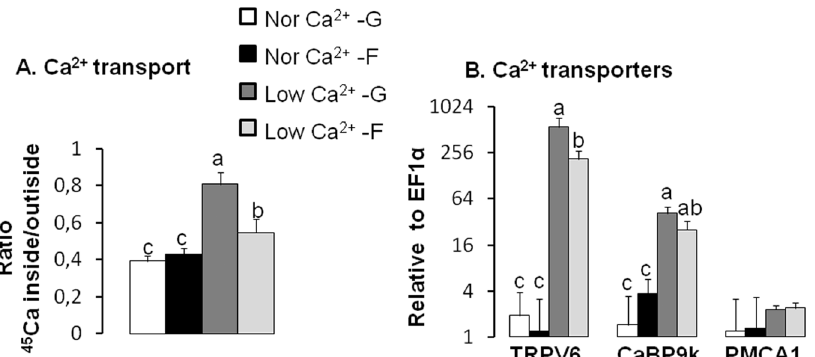
Figure 1. Fructose-fed mice demonstrate an inhibition of compensation for intestinal Ca 2 + transport rate and transporter expression induced by dietary Ca 2 + -deficiency. (A) Ca 2 + transport was measured using everted duodenal sacs from mice fed diets containing either 43% glucose or fructose, in combination with either normal or low Ca 2 + . Active transepithelial Ca 2 + transport from the luminal to the basolateral compartment was expressed as a ratio of the final quantity of 45 Ca 2 + inside/outside of the everted gut sacs. (B) mRNA expression levels of intestinal Ca 2 + (TRPV6, CaBP9k, PMCA1) transporters. All expression data were analyzed by real-time PCR using EF1 a as a reference and then normalized to levels in mice fed a normal Ca 2 + -glucose diet (Nor Ca 2 + -G). Data are means 6 SEM ( n =6 per group). Differences ( P , 0.05) among means are indicated by differences in superscript letters, as analyzed by 1-way ANOVA LSD. Thus, within a gene of interest, bars with superscript ‘‘a’’ are . bars with ‘‘b’’ which in turn are . bars with ‘‘c’’. Dietary fructose inhibits compensatory increases in Ca 2 + transporter activity and expression